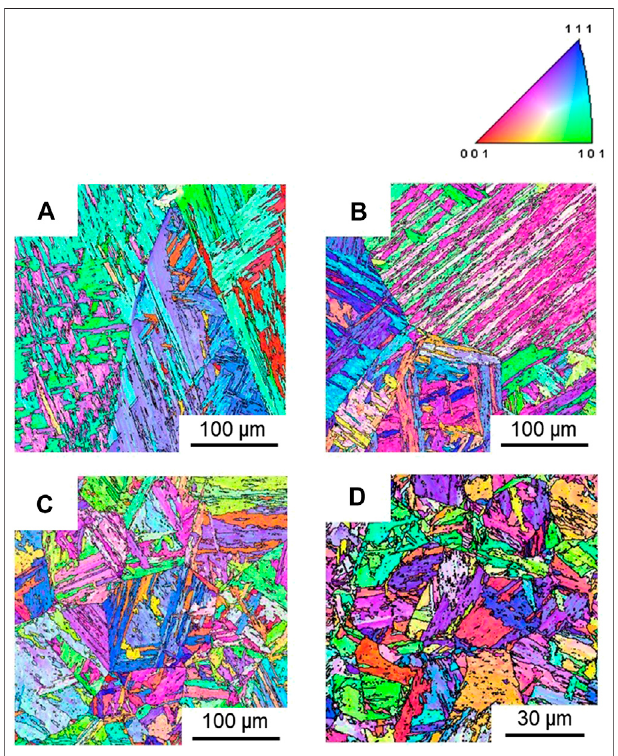
FIGURE 2 | EBSD orientation color maps of the martensite microstructures of the specimens austenitized at (A) 1,100 ° C, (B) 950 ° C, (C) 900 ° C, and (D) 830 ° C and then water-quenched. Colors in the color maps indicate crystallographic orientations perpendicular to the observed sections, according to the key stereographic triangle shown in the fi gure.